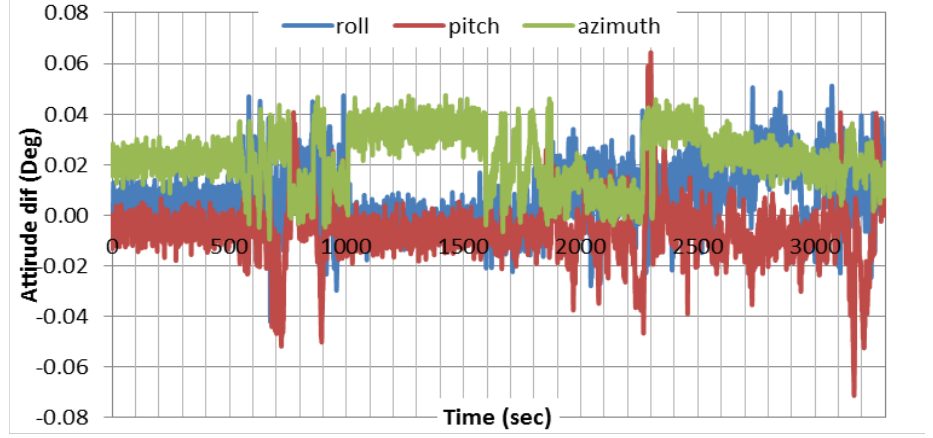
Figure 6. Attitude estimation results using EKF, referenced to differential-based integrated system.